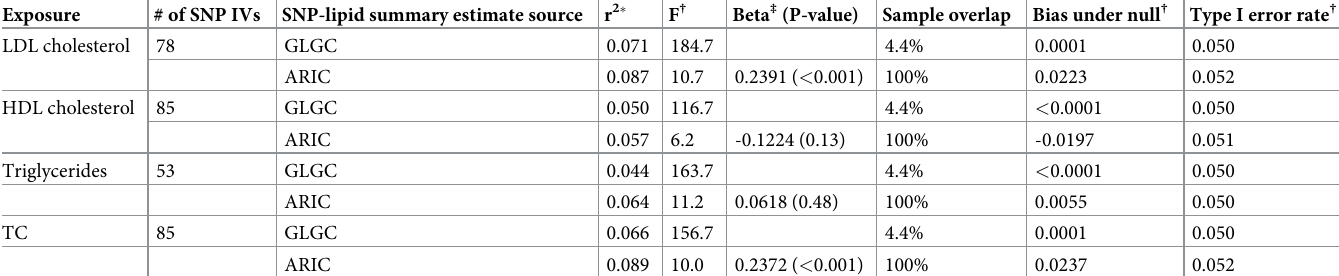
Percentage of variance in the lipids explained by the SNPs